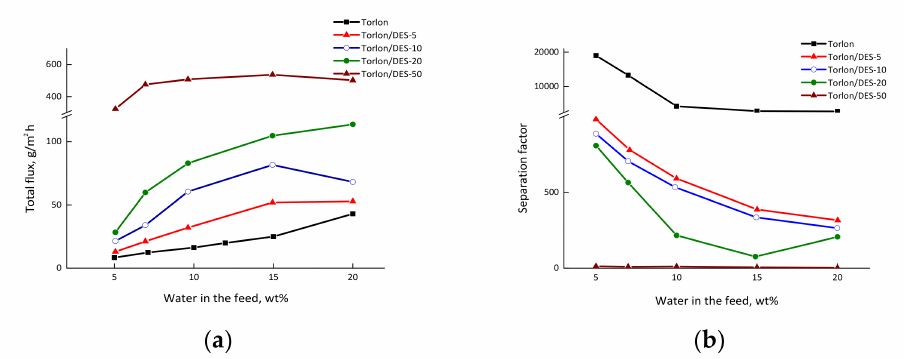
Figure 9. Dependences of ( a ) the total flux and ( b ) the separation factor on water concentration in the feed for the pervaporation of water–IPA mixture using the Torlon-based membranes at 50 ◦ C. Comparison with Literature Data